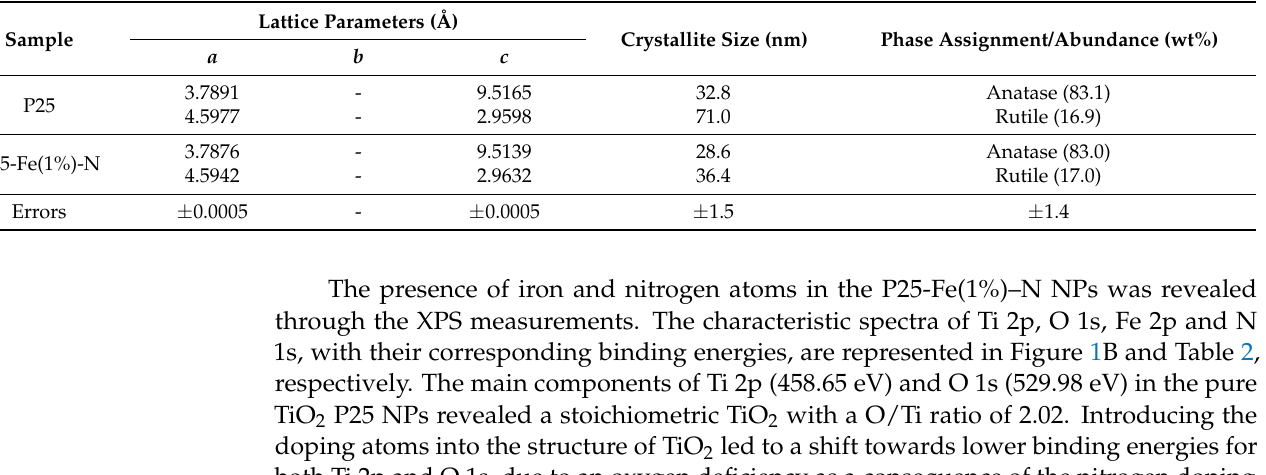
Table 1. Lattice parameters, crystallite size, phase assignment and relative abundance of the P25 and P25–Fe(1%)-N NPs